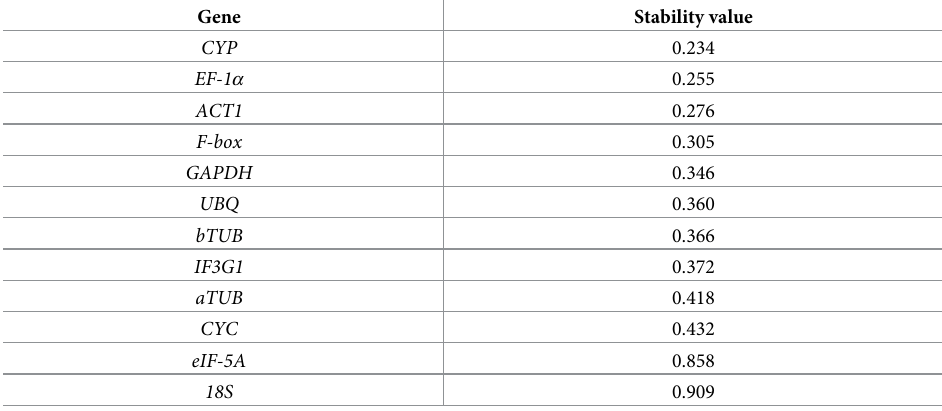
Table 2. The expression stability of the candidate reference genes determined by